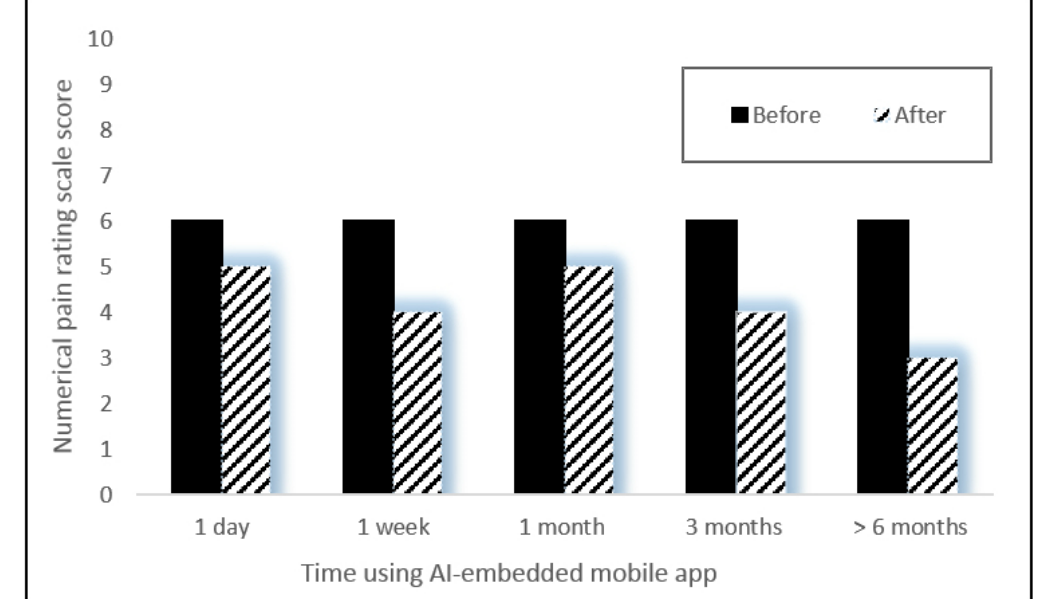
Figure 4. The reported difference in Numerical Pain Rating Scale changes reported by participants of different